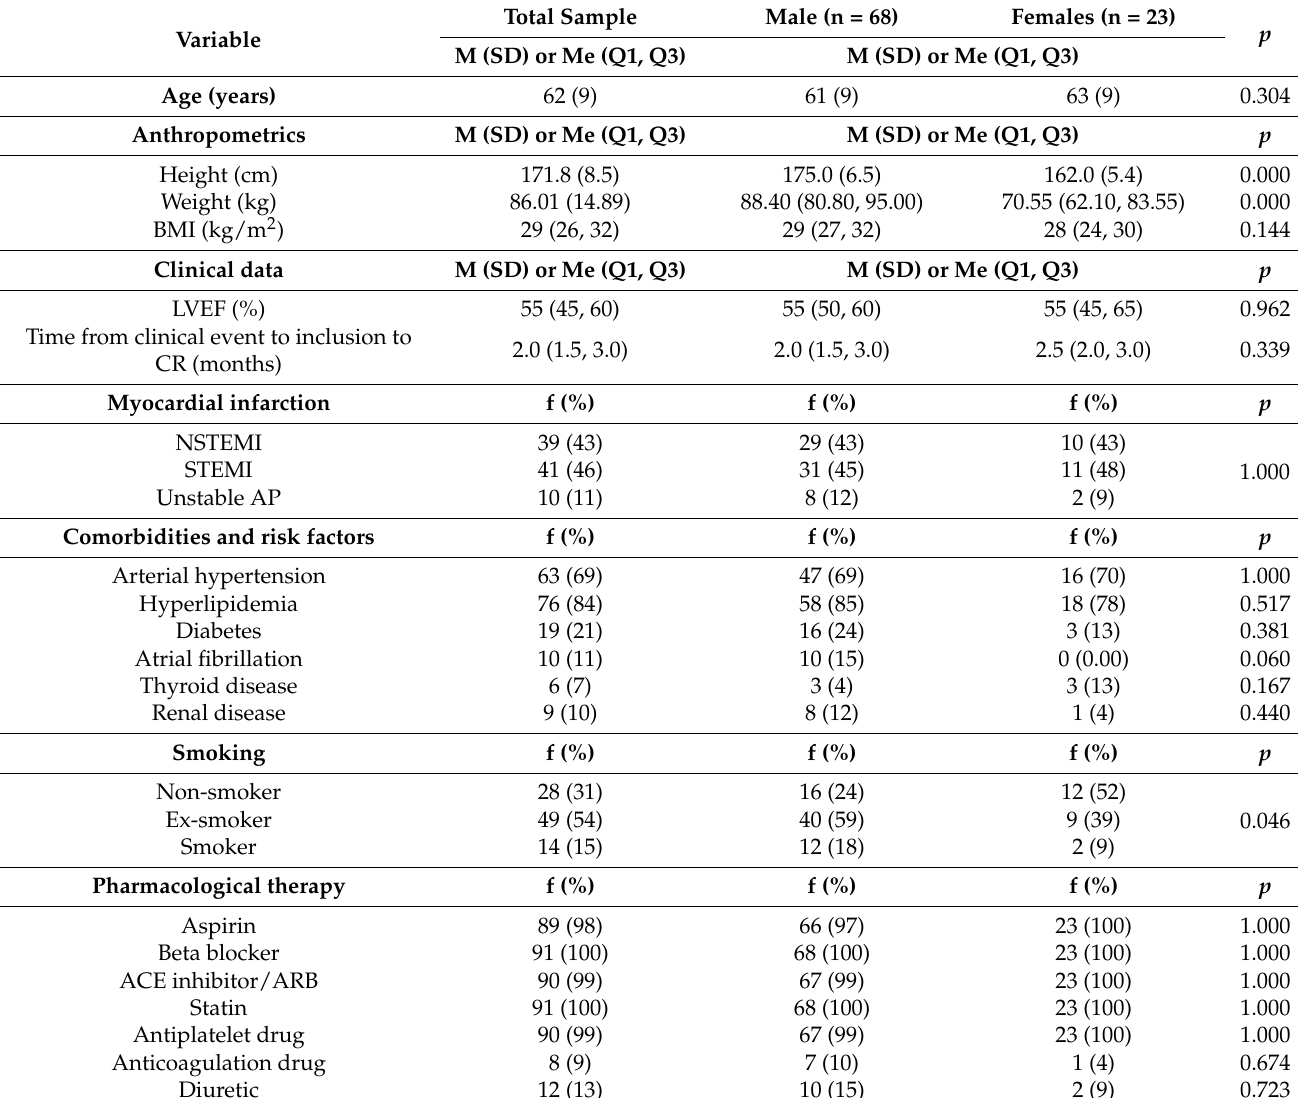
Table 1. Baseline clinical and demographic